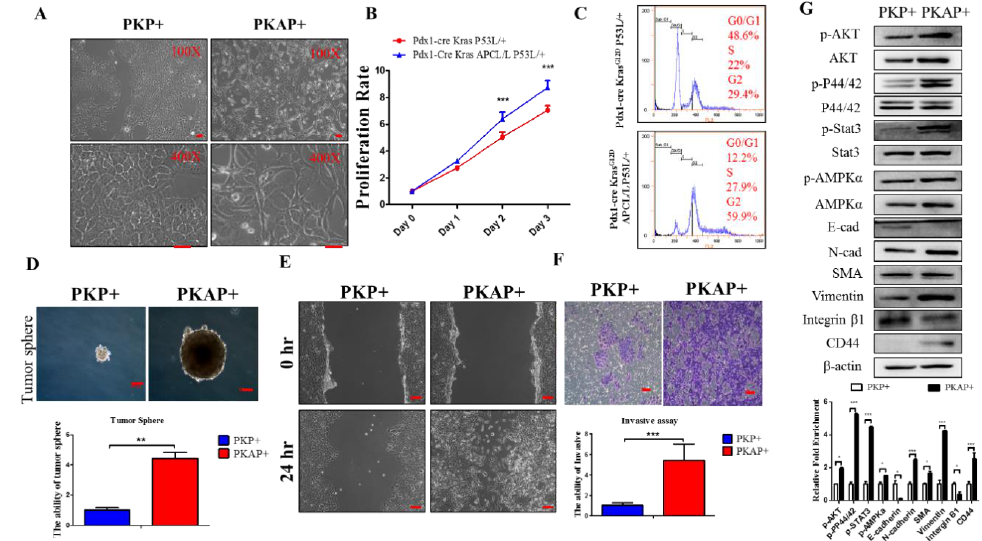
Figure 2. APC loss promotes tumorigenesis and cell motility in PDAC. ( A ) Cell morphology of primary murine PDAC cells from Pdx1-Cre; KrasG12D, p53L/+ (PKP+) mice and Pdx1-Cre, KrasG12D, APCL/L, and p53L/+ (PKAP+) mice. ( B ) The analysis of PKP+ and PKAP+ tumor